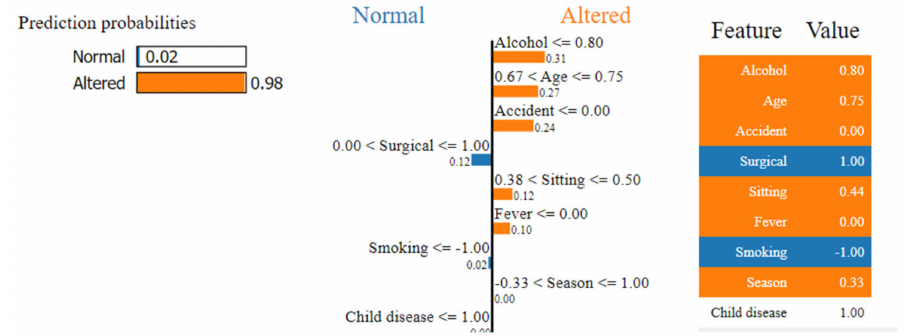
Figure 7. Local visualization of the proposed